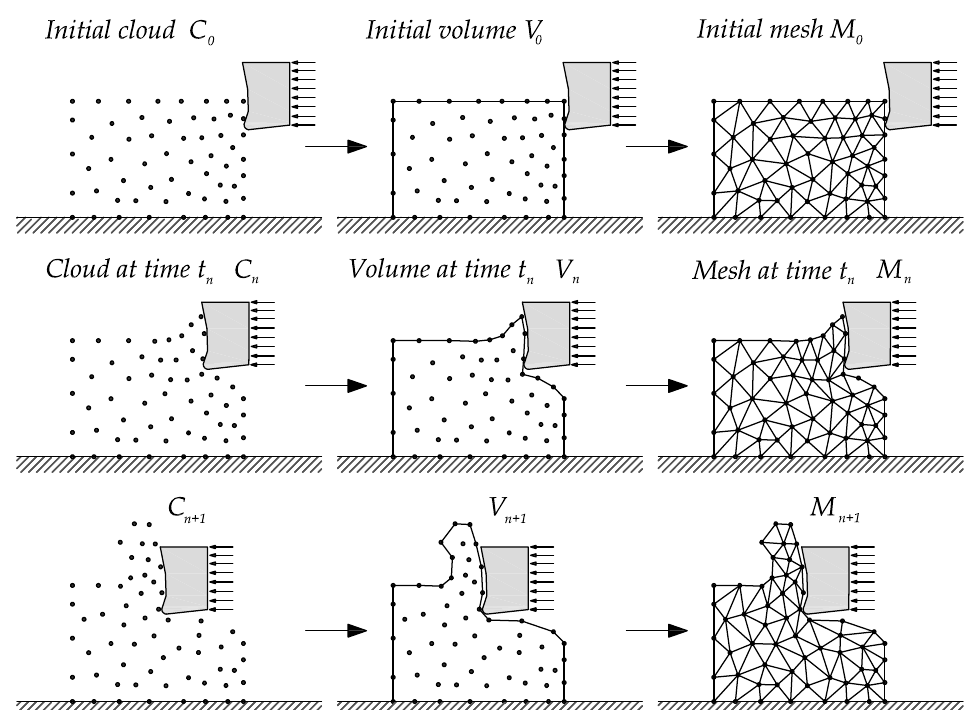
Figure 1. Remeshing steps in a standard Particle Finite Element Method (PFEM) numerical